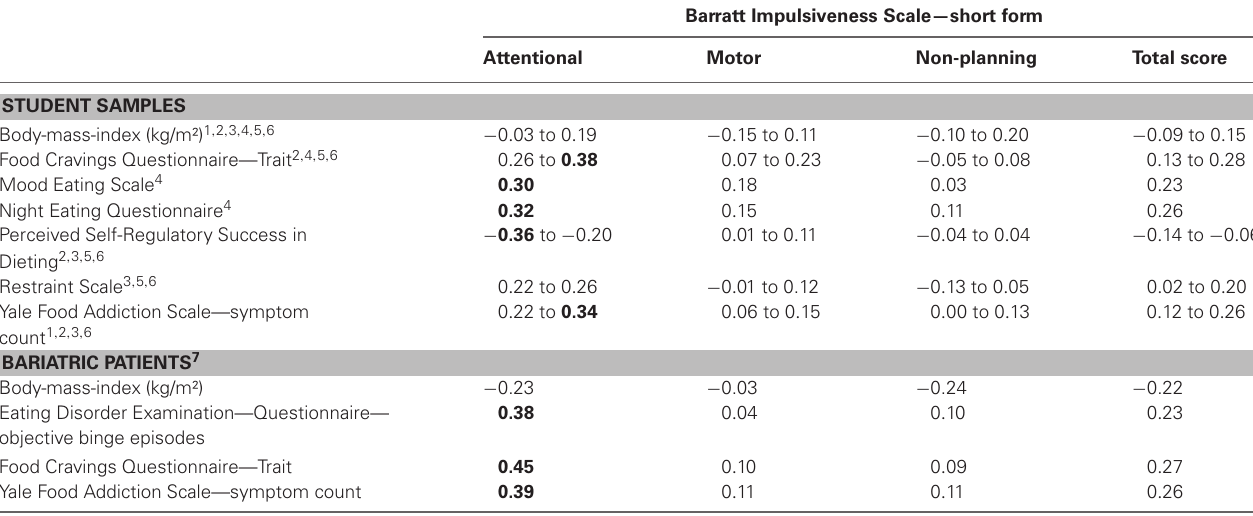
Table 1 | Correlations between the Barratt Impulsiveness Scale—short form , body-mass-index, and various self-report measures associated with